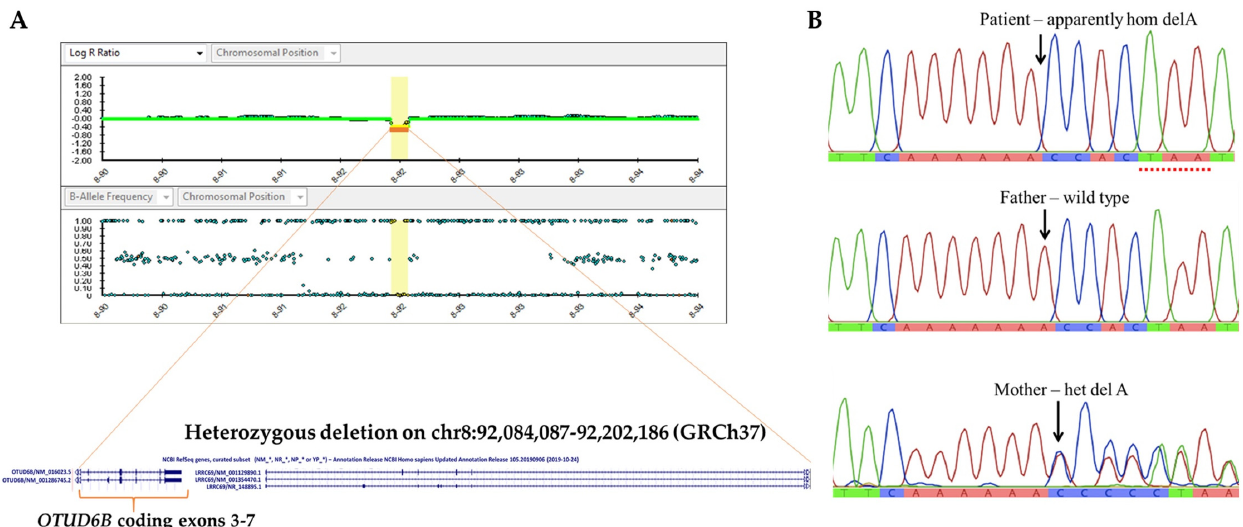
Figure 2. OTUD6B chromosomal and nucleotide mutations. ( A ) CytoSNP-850 K array showing Log R ratio (LRR) plot and B-allele frequency (BAF) plot and revealing a 0.118 Mb deletion of chromosome 8q21.3. ( B ) Genomic DNA sequence of exon 6 showing delA in the patient and her Figure 2 . OTUD6B chromosomal and nucleotide mutations. ( A ) CytoSNP ‐ 850 K array showing Log R ratio (LRR) plot and B ‐ allele frequency (BAF) plot and revealing a 0 . 118 Mb deletion of chromosome 8q21 . 3. ( B ) Genomic DNA sequence of exon 6 showing delA in the patient and her father .